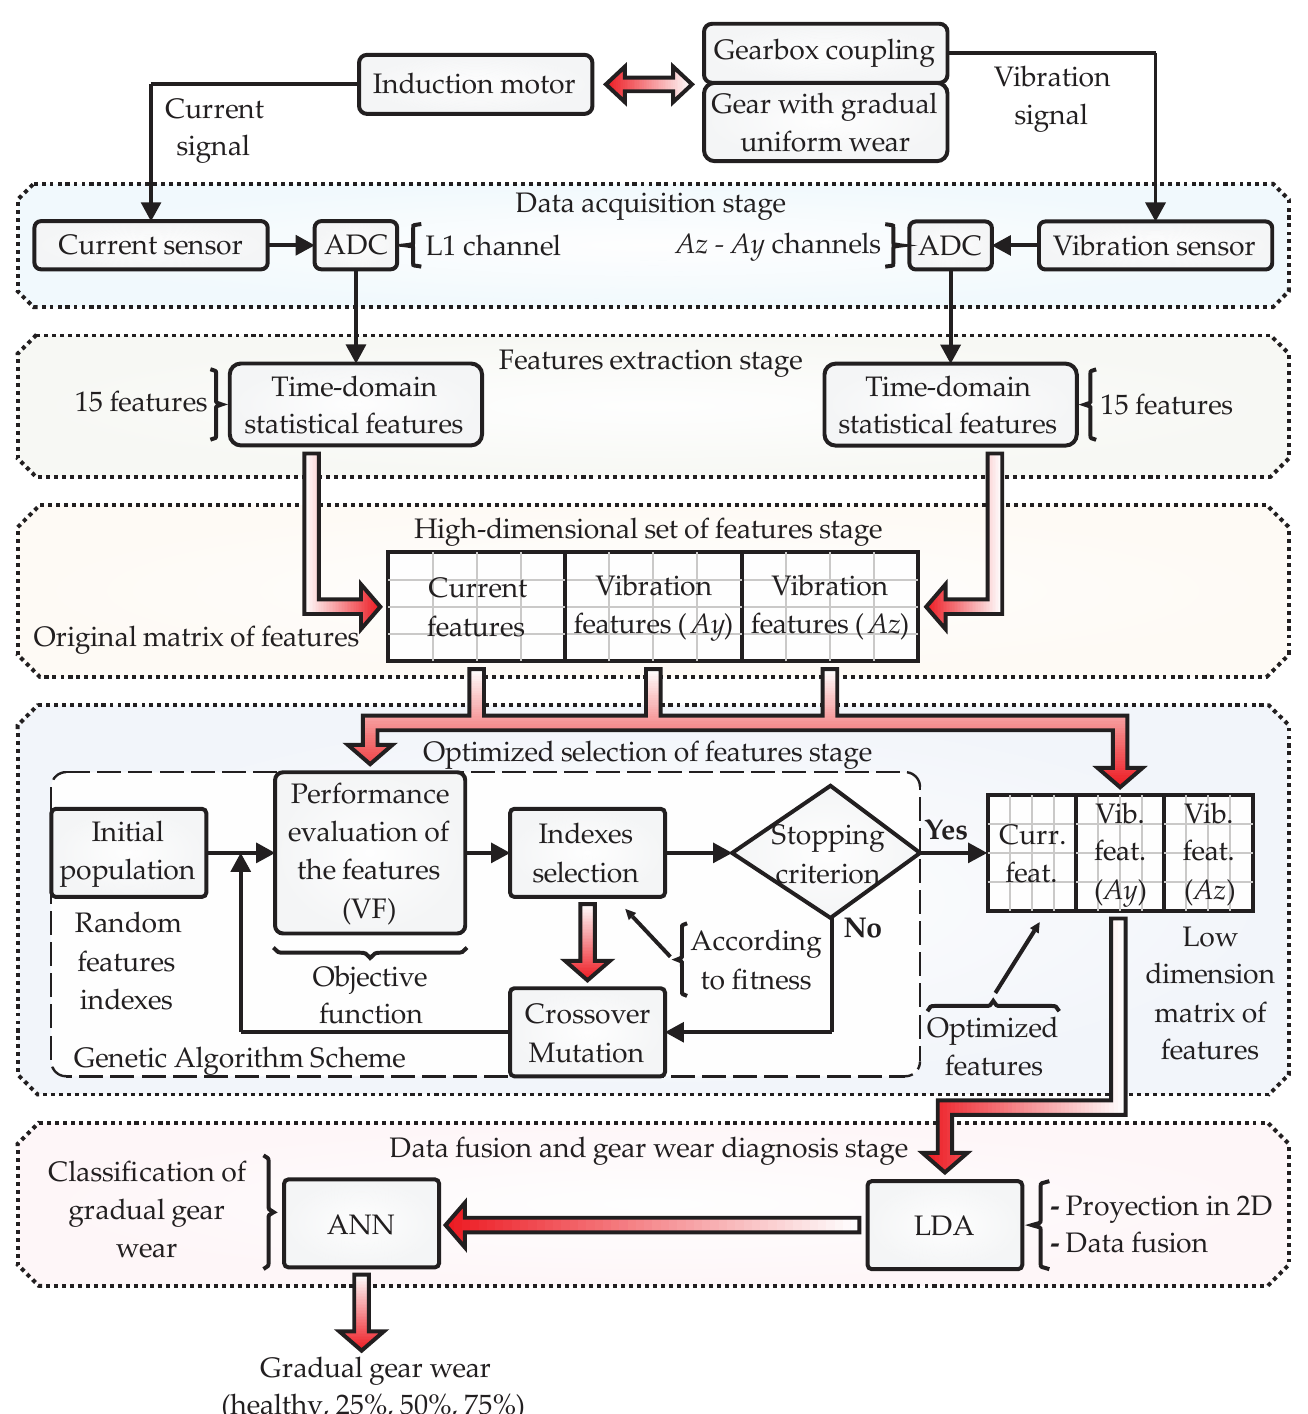
Figure 4. Block diagram of the proposed methodology.